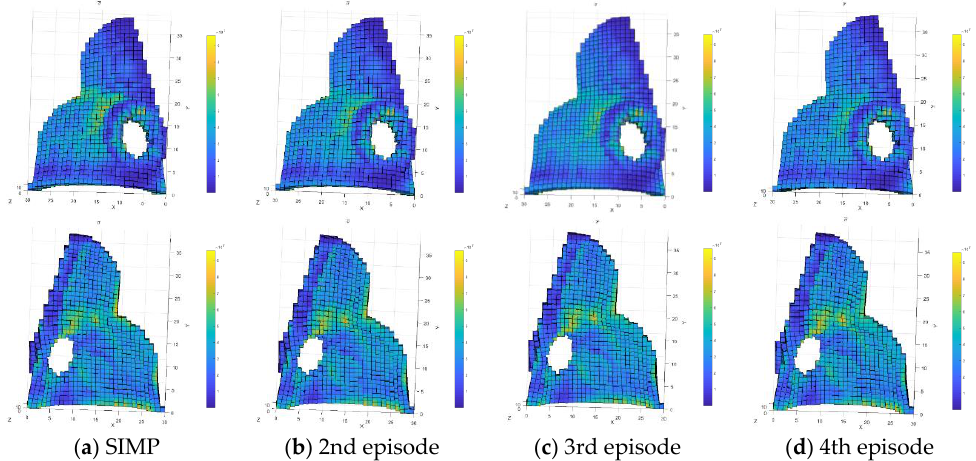
Figure 16. The stress contour of the upper body (after optimization).